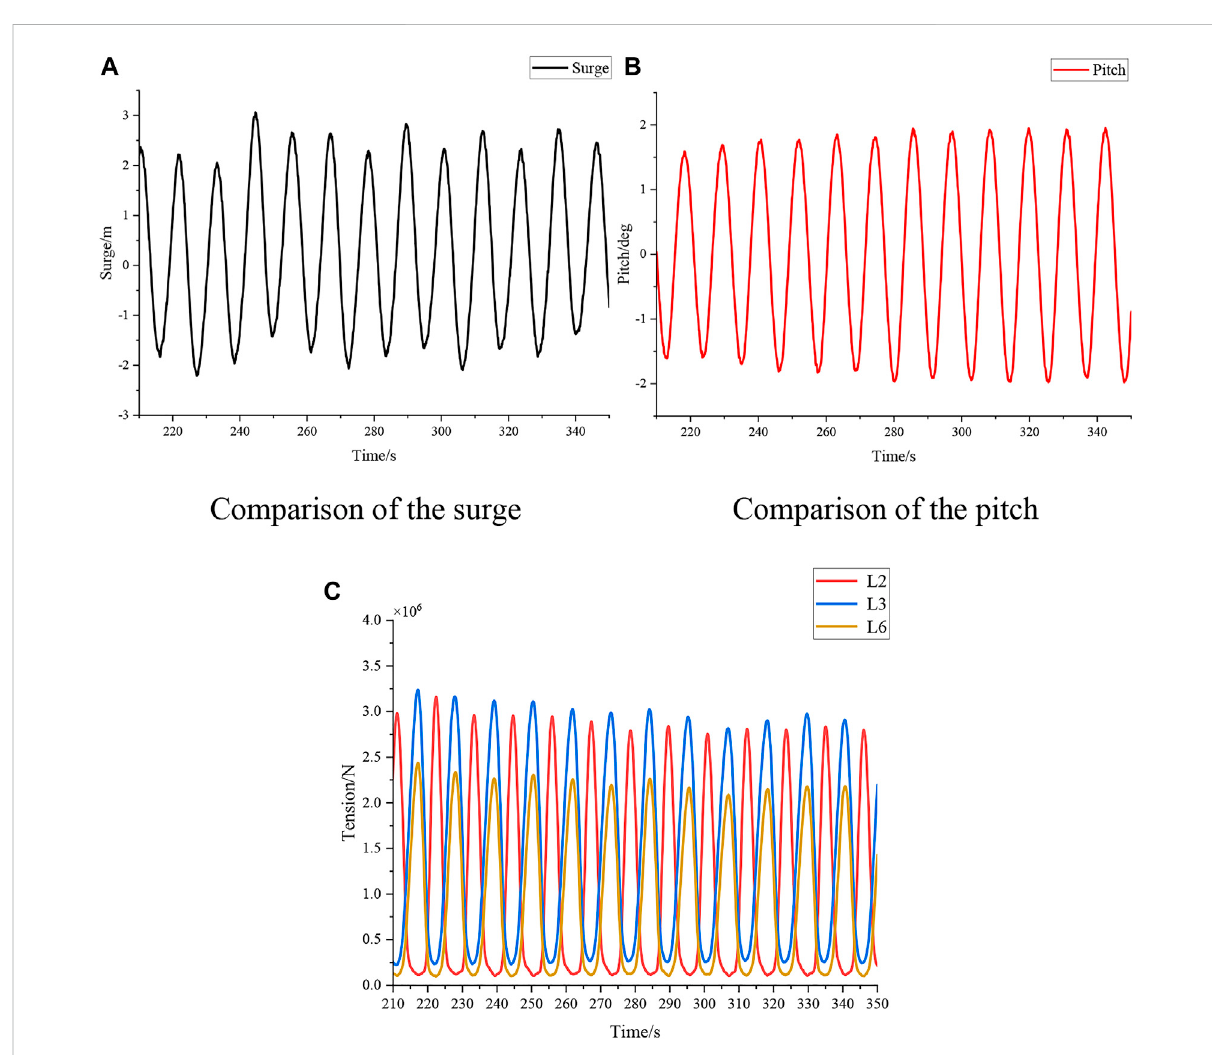
FIGURE 18 The characteristics of mooring system in shallow water. (A) Comparison of the surge. (B) Comparison of the pitch. (C) Comparison of the mooring force of different mooring